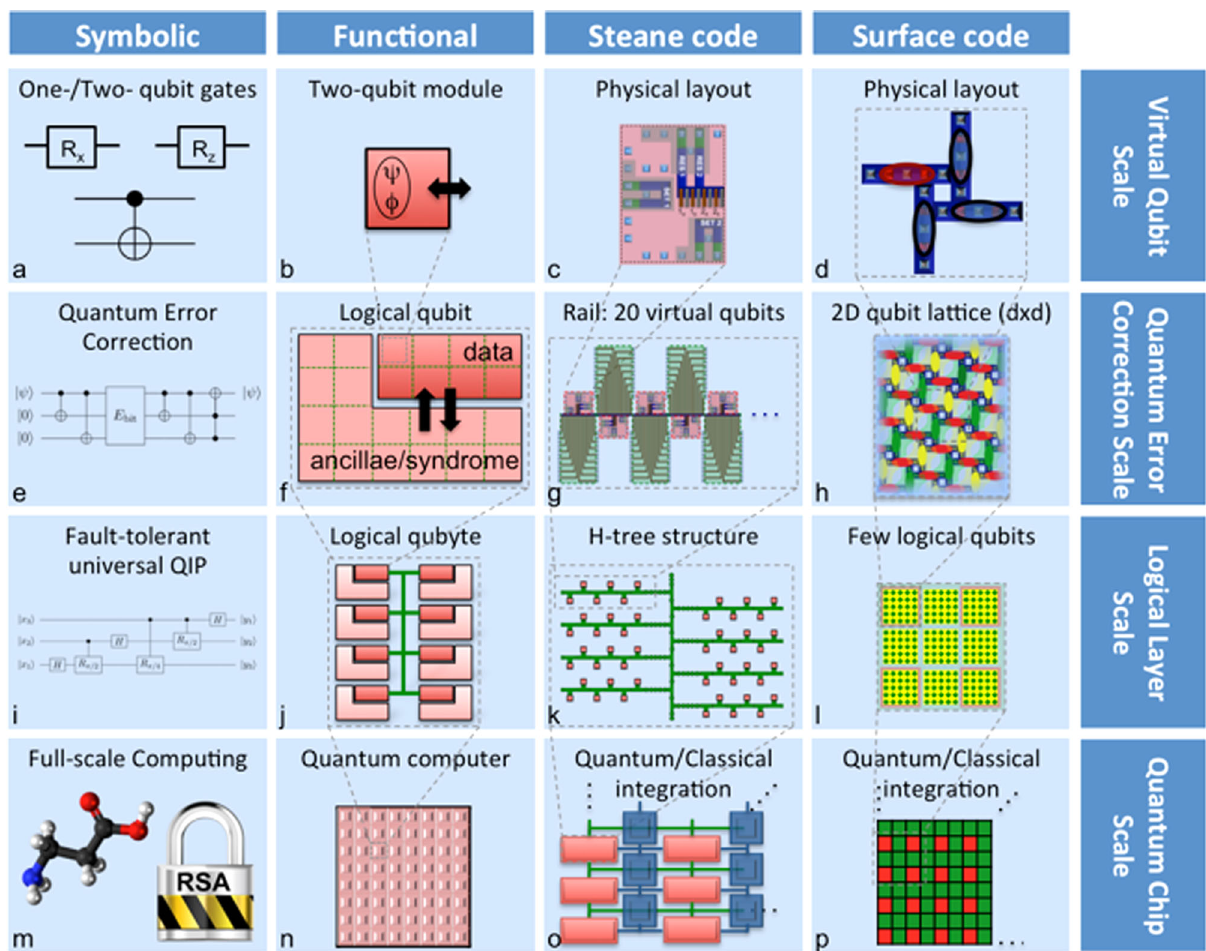
Fig. 2 Representation of QIP at different scales of integration according to the different layers of implementation. The fi rst column represents the different scales of integration with symbolic diagrams. The second one is a functional representation of the blocks required to execute the corresponding operations. The third column provides the physical layer implementation by the Steane code based on the modules d , c , and t , while the fourth column by the surface code. Each oval indicates a double QD qubit. In panel h , the representation of the 2D nearest neighbor array shows the virtual data qubits in red for the surface code and ancillae for the x ( yellow ) and z ( green ) stabilizer measurements. The four rows represent four scales of integration: the virtual qubits by their physical layout, the QEC scale for logical qubits, the logical layer scale, and fi nally the quantum chip scale enabling quantum algorithms such as Shor ’ s factoring and quantum simulations. The logical layer scale assesses fault-tolerant computation from few logical qubits and it has been used to calculate the area of a single logical qubit of the Steane code by including